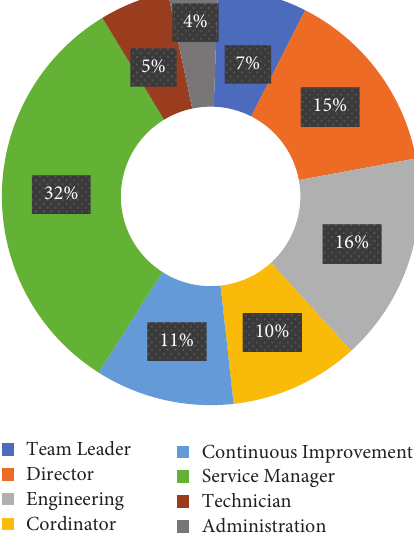
Figure 12: Types of participating